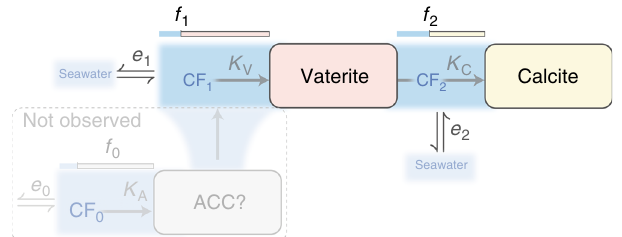
Fig. 7 The hypothesised double-fractionation mechanism. Initially, vaterite is formed from a calcifying fl uid (CF 1 ), which has a starting composition similar to seawater, and exchanges ions with the external environment ( e 1